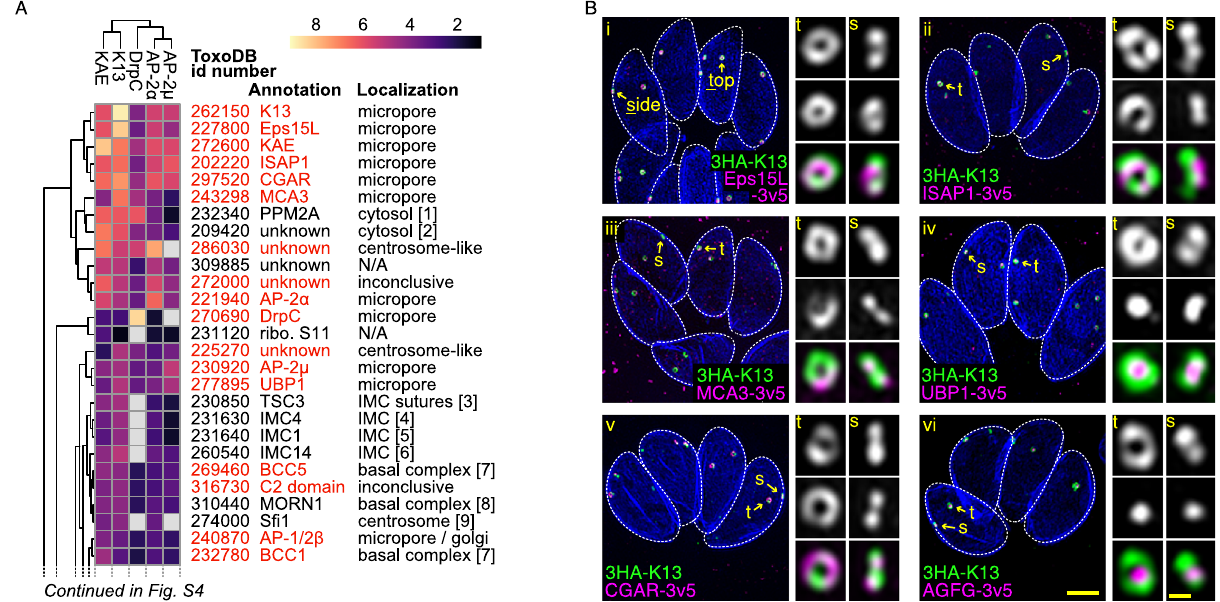
Fig. 2 | Toxoplasma micropore shows conservation with the Plasmodium cytostome but also possesses unique proteins. A Heat map of BioID-enriched proteins determined with fi ve bait proteins. Results are clustered according to similarity of results between baits and ordered by fold enrichment (colours). Pro- teinsreportertaggedinthisstudyareshowninred,andinferredcelllocationgiven. Numbers in brackets refer to previously published localizations: [1] 90 , [2] 91 , [3] 42 , [4] 92 , [5] 93 , [6] 94 , [7] 95 , [8] 96 , [9] 97 . Full heat map is shown in Fig. S4A. B Collapsed